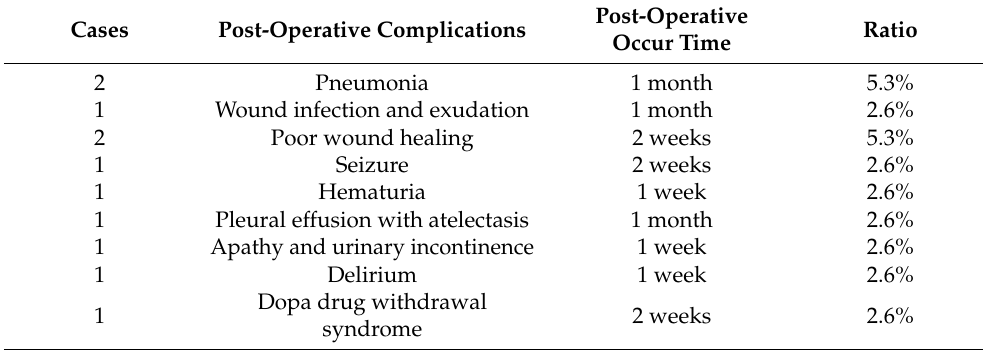
Table 3. Post-operative